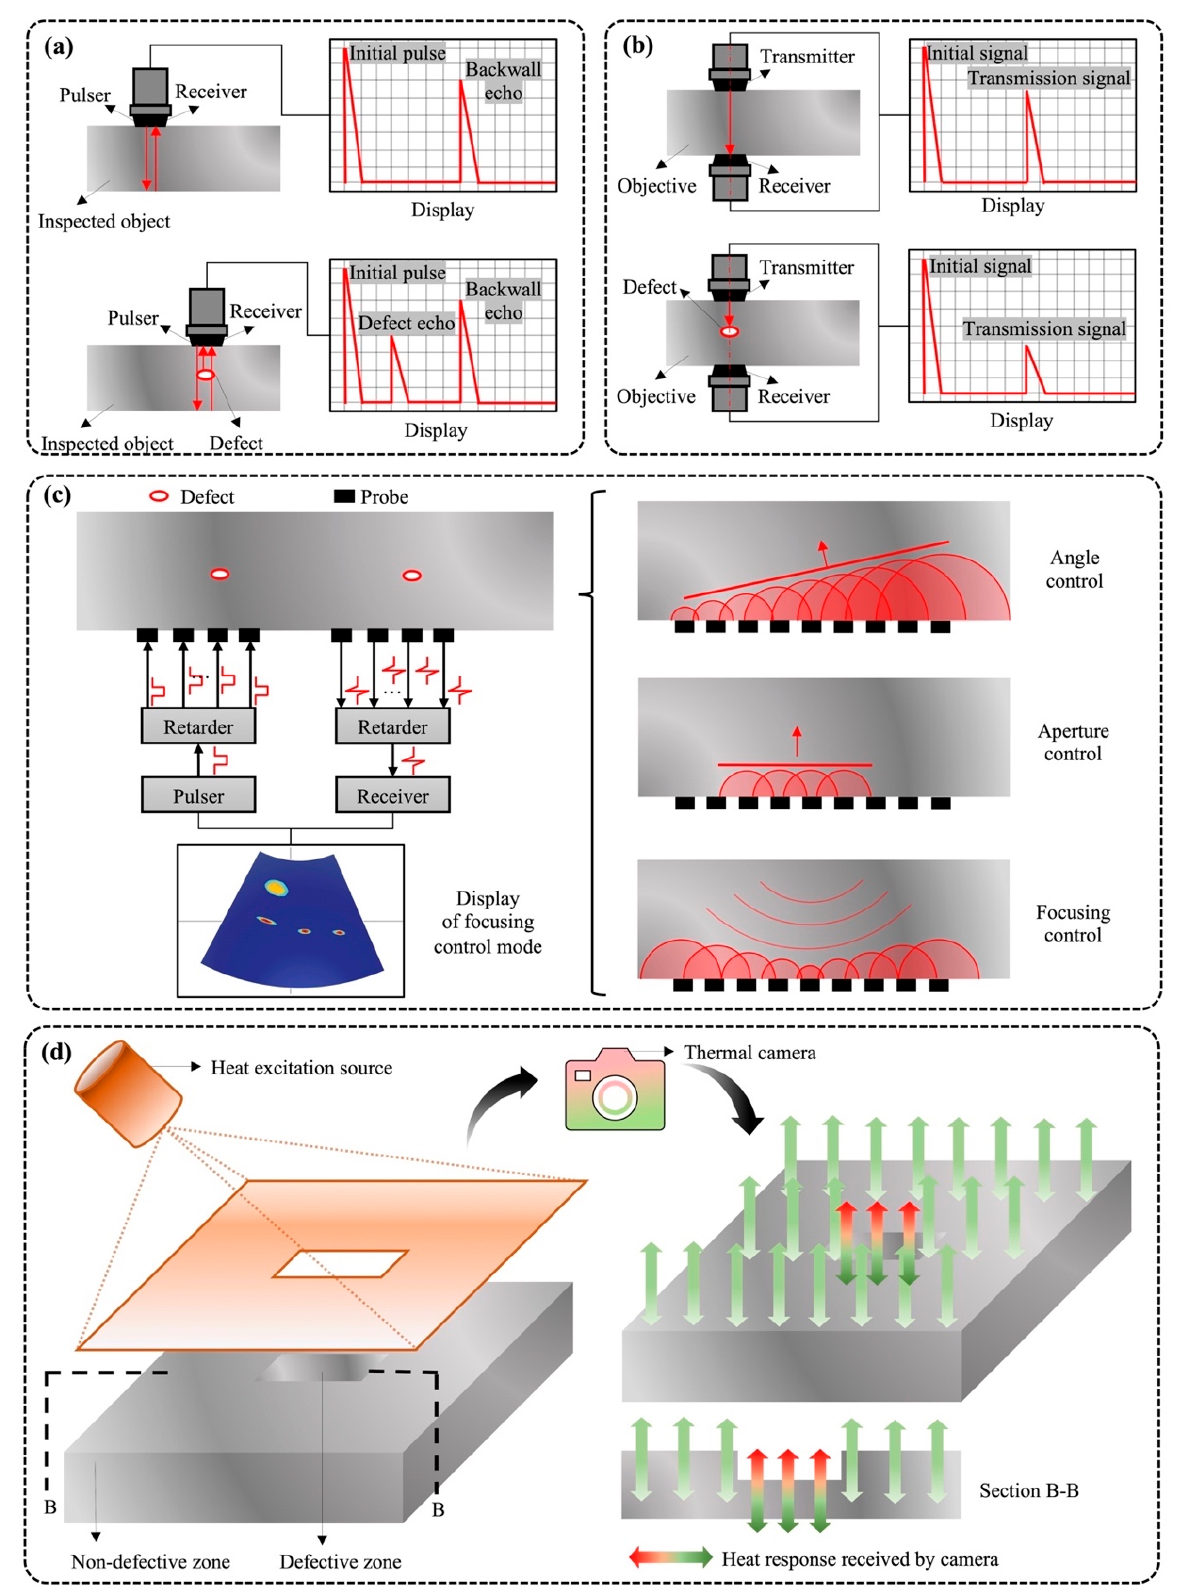
Figure 3. Advanced non-destructive technologies for aluminum window detections. ( a ) Ultrasonic wave transmission technology. ( b ) Ultrasonic wave reflection technology. ( c ) Phased array technology and phased array focal laws. ( d ) Active infrared thermal image.